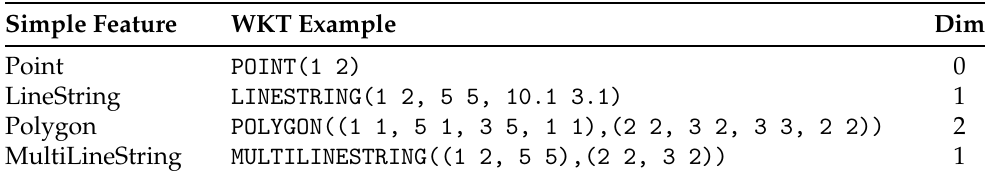
Table 1. Used OGC Simple Features and WKT